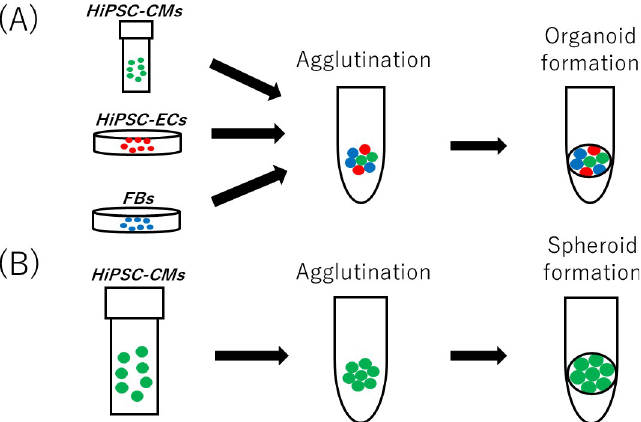
Fig 1. Generation of cardiac organoids in a 96-well spindle plate (A). Generation of pure hiPSC-CM spheroids in a 96-well spindle plate